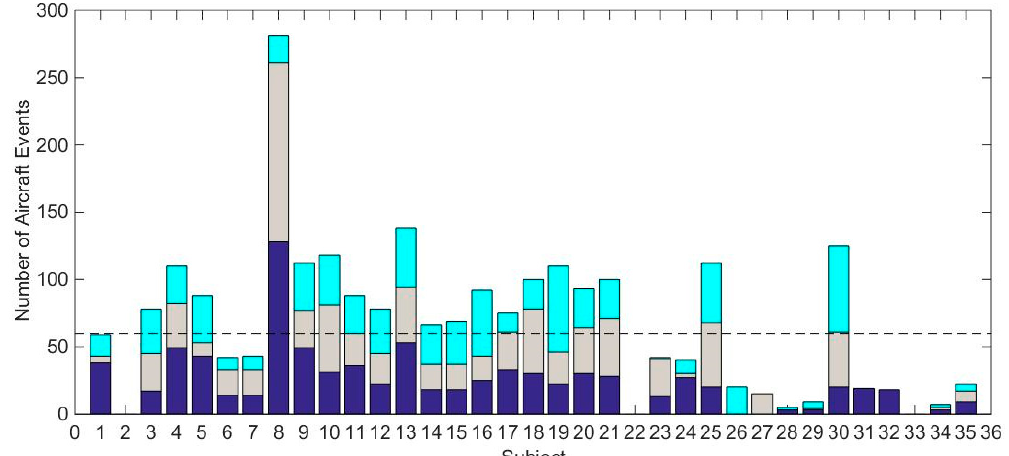
Figure 5. Number of aircraft noise events per subject near PHL airport for each night (4 out of the 36 participants had no audible events; this was due to masking noise from a TV, fan, or air conditioner). The colors indicate study nights 1 (purple), 2 (gray), and 3 (turquoise).